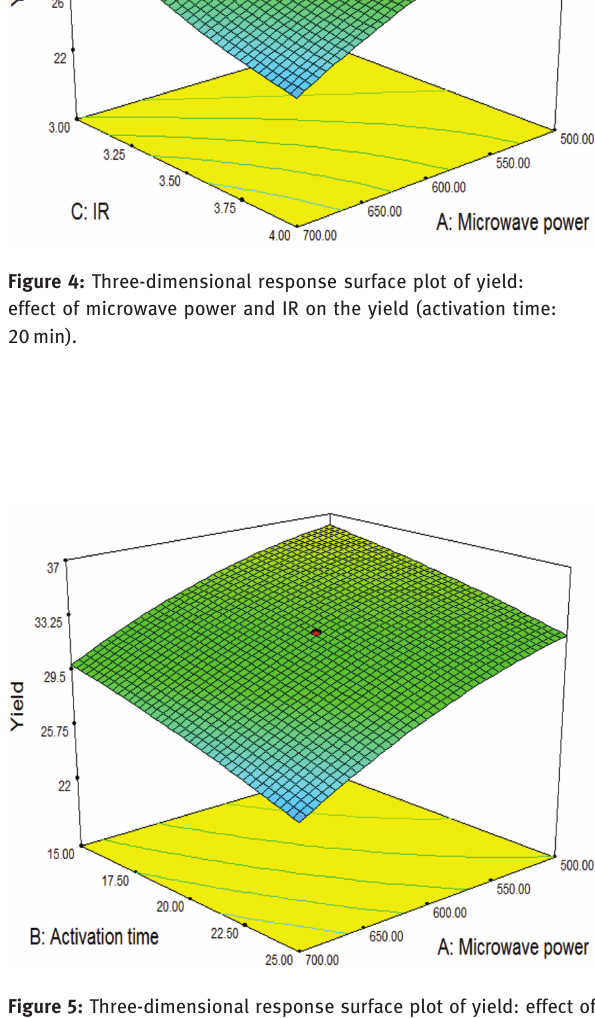
Figure 5: Three-dimensional response surface plot of yield: effect of microwave power and activation time on the yield (KOH/C weight ratio: 3.5).